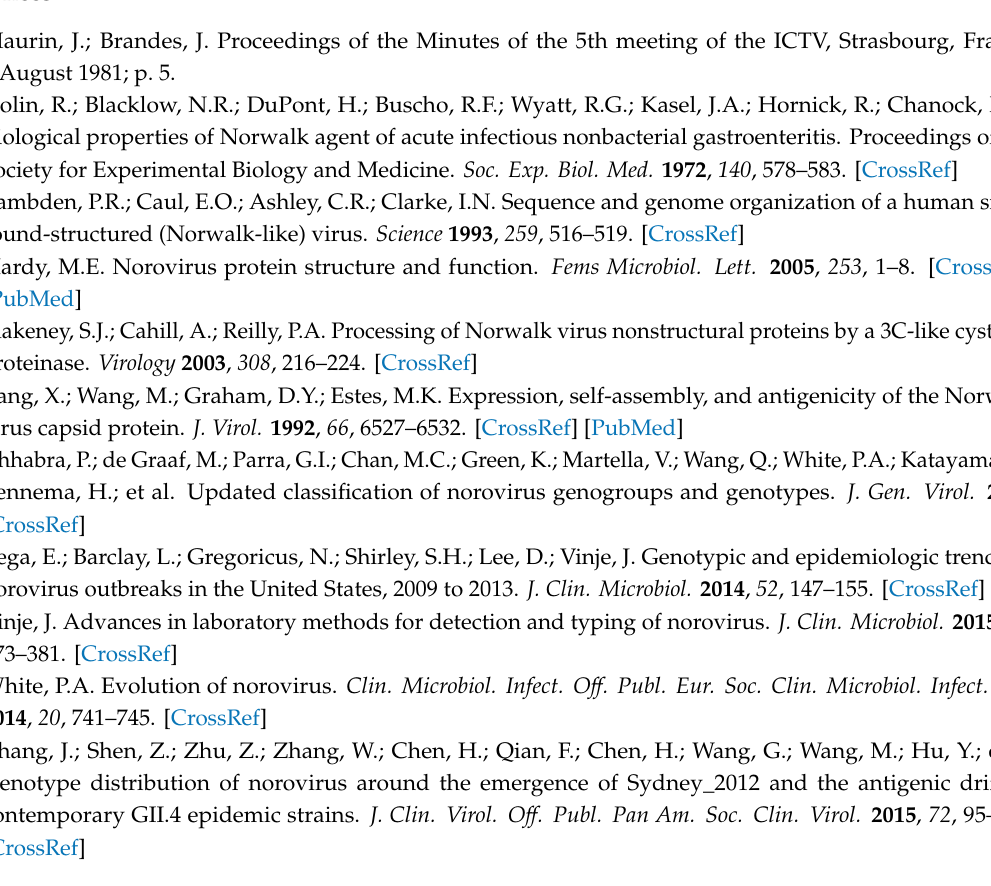
Figure S1: ORF1-2 Junction PCR, Figure S2: Detection of GII.4 Sydney HuNoV p48 by ELISA, Figure S3: Approximately one-half of HuNoV g.e. in stool are associated with exosomes, Figure S4: Vero cells support GII.4 Sydney HuNoV across a range of MOIs. Figure S5: Improvement of GII.4 Sydney HuNoV replication by trypsin addition is MOI-dependent, Figure S6: LRGUK gene KO in Vero cells improves GII.3 HuNoV replication,